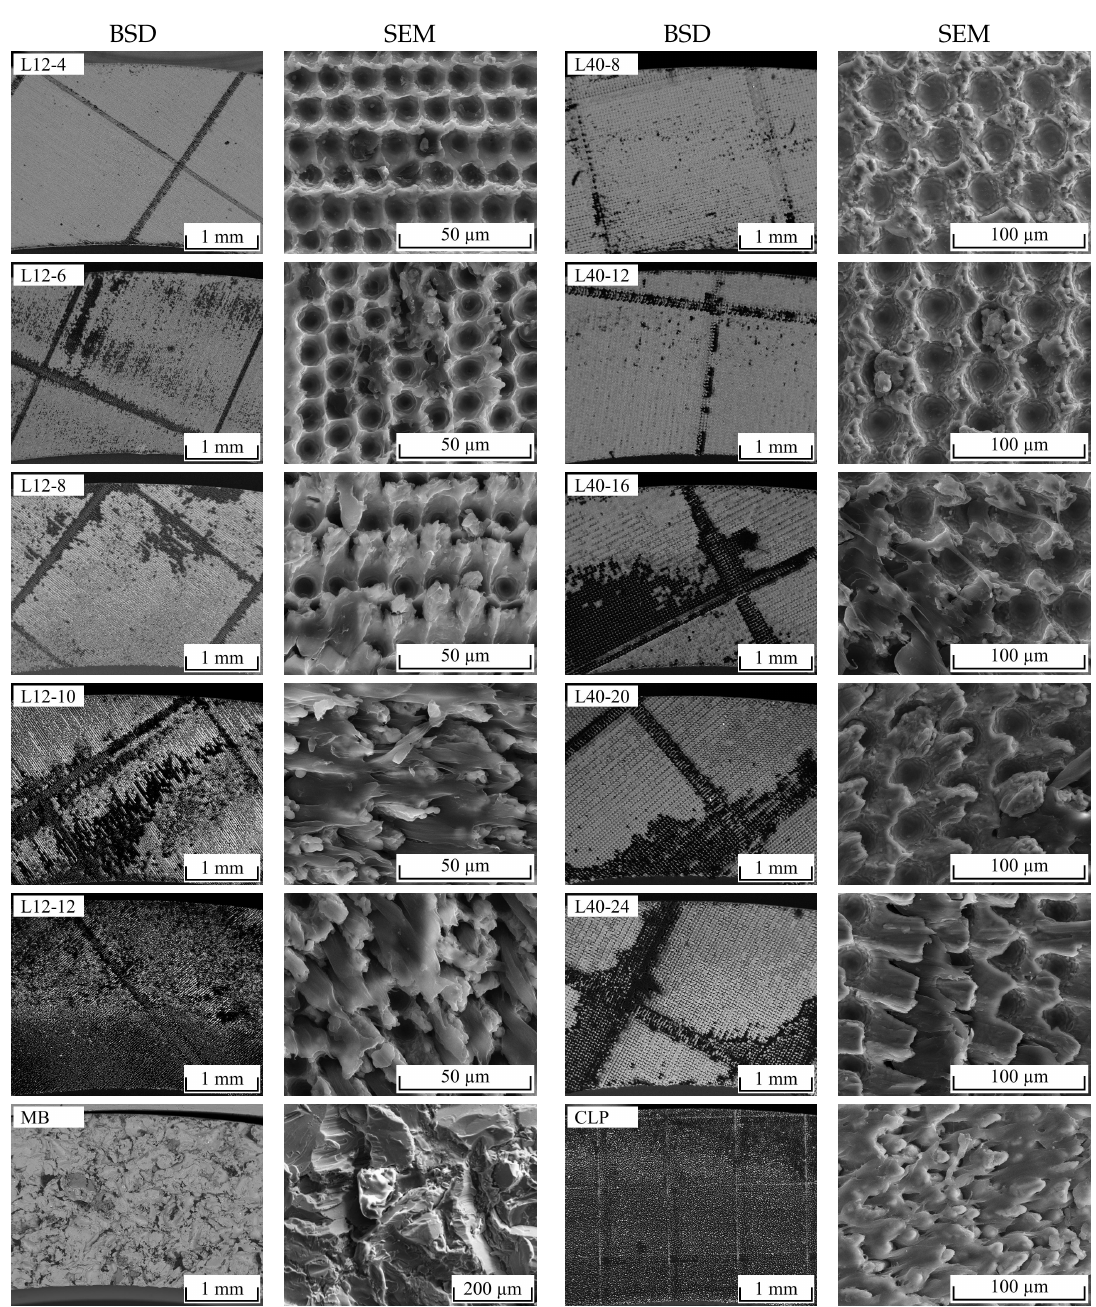
Figure 10. BSD ( left ) and SEM ( right ) images of the fractured metal surfaces of all investigated surface